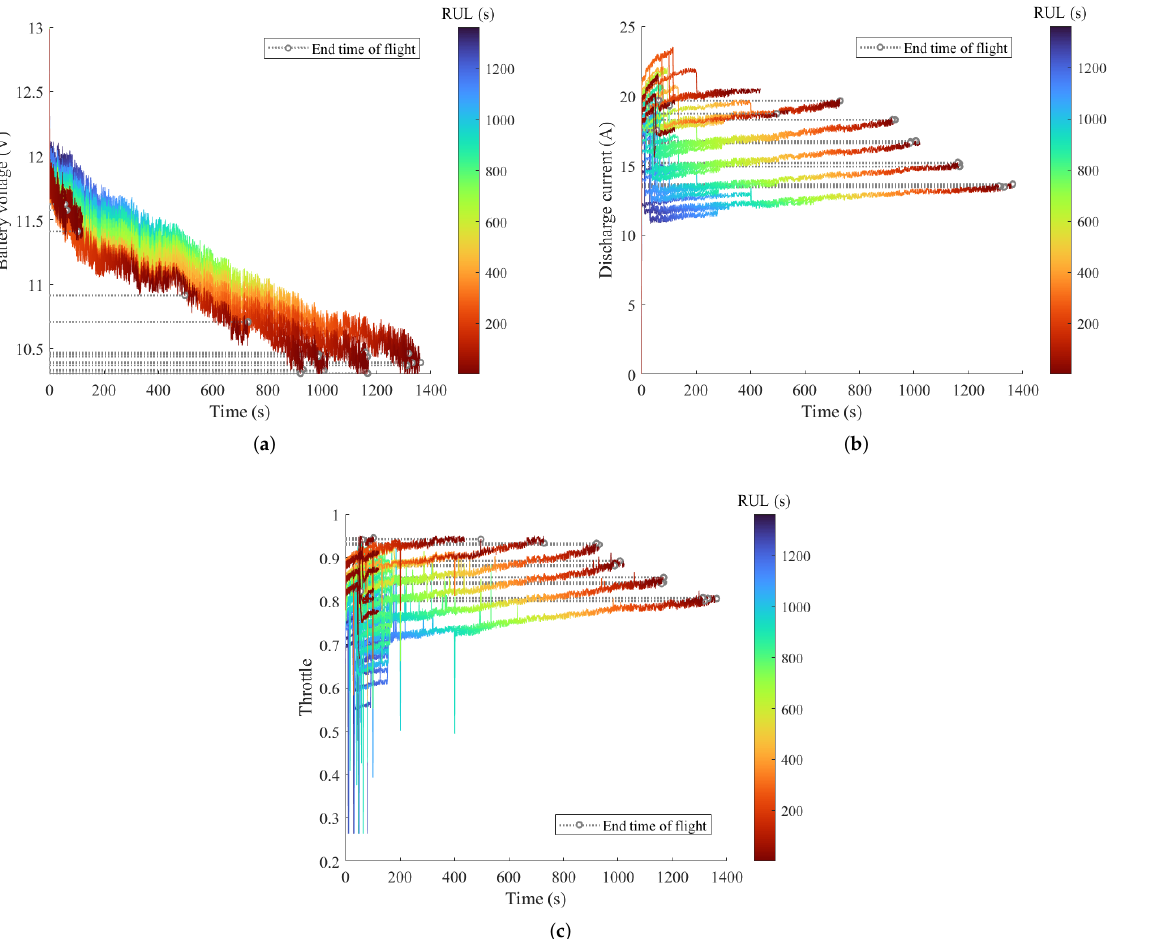
Figure 6. Multi-sensor signal in the historical flight data of the highly maneuverable QUAV. ( a ) Battery voltage. ( b ) Discharge current. ( c )